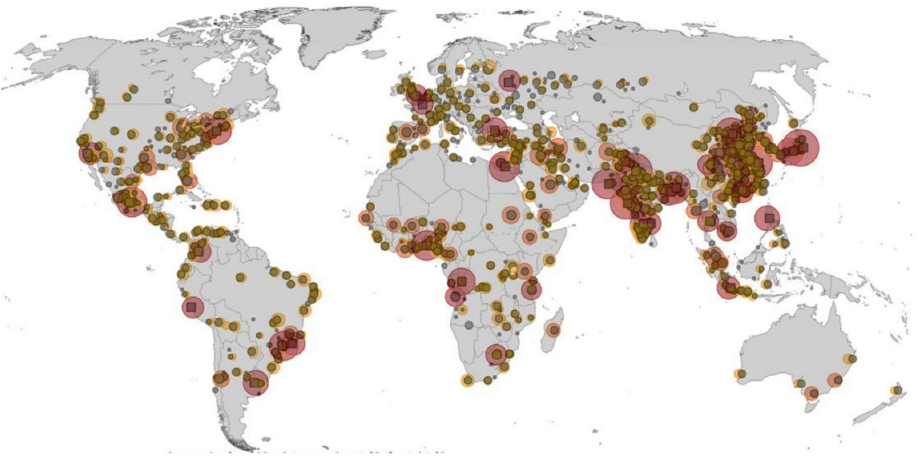
Figure 4. Urbanization and the growth of the network of megacities in the world, forecast model for 2030 (red—megacities of 10 million and more; orange—from 5 to 10 million; yellow—from 1 to 5 million), 2014. Compiled on the basis of an interactive map tracking global changes in the urban population from 1950 to 2030, UN data (source: https://www.economist.com/node/21642053, accessed on 13 August